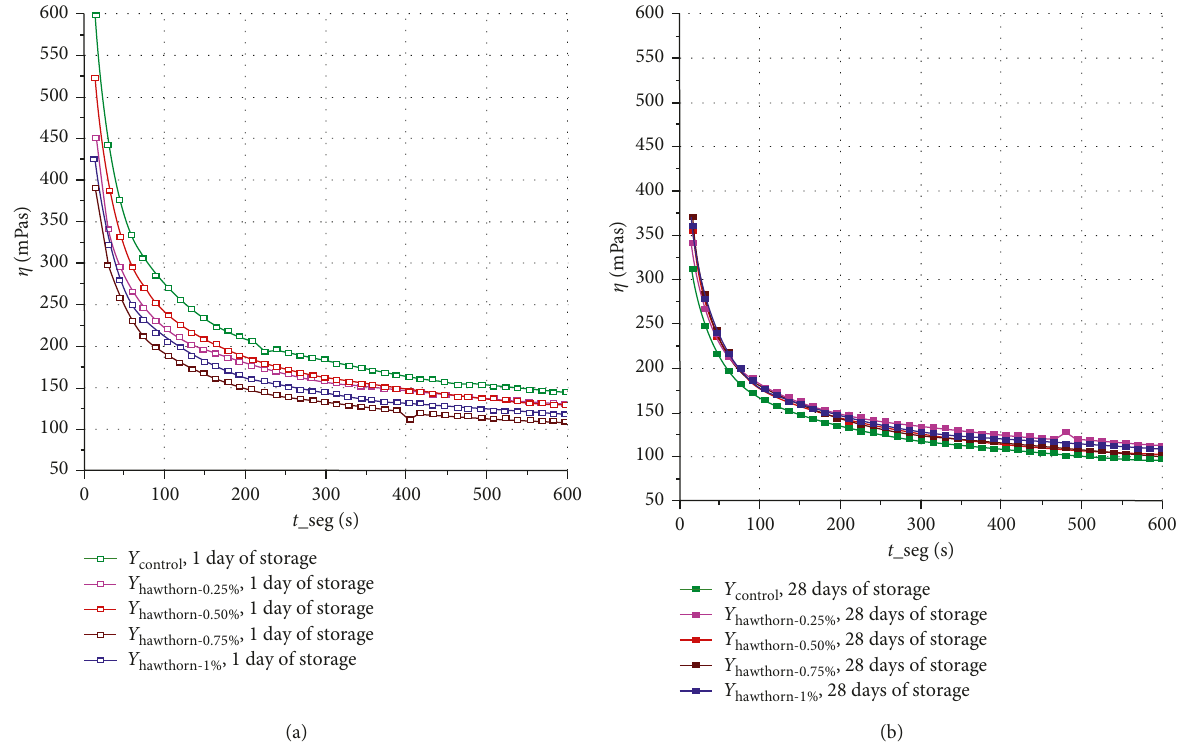
Figure 2: Curve of viscosity versus time of testing thixotropy of yogurt with hawthorn ( Crataegus monogyna ) extract: (a) 1 day of storage; (b) after 28 days of storage.